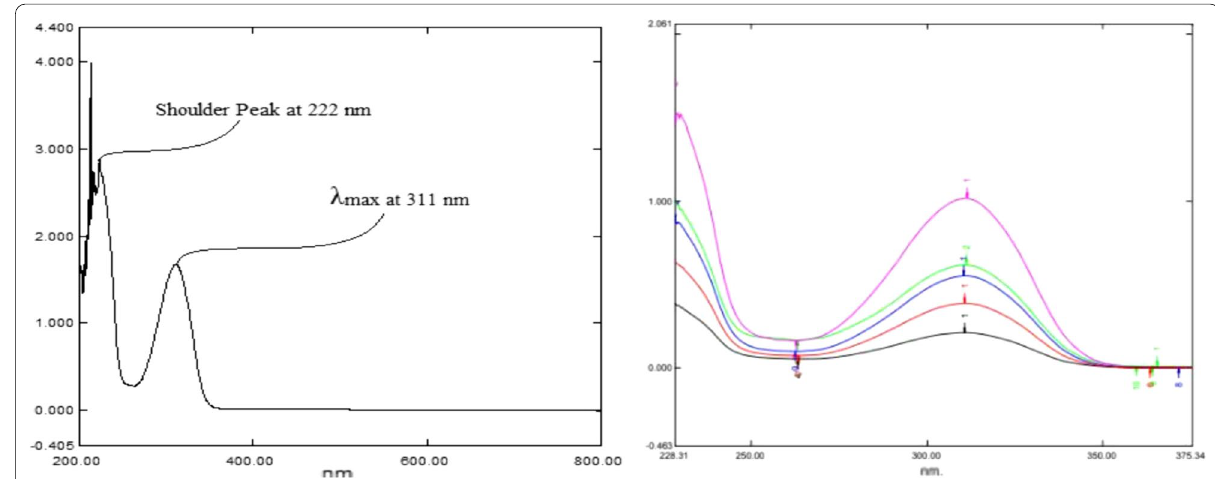
Fig. 6 a λ max determination of pirfenidone b Overlay spectra of pure pirfenidone